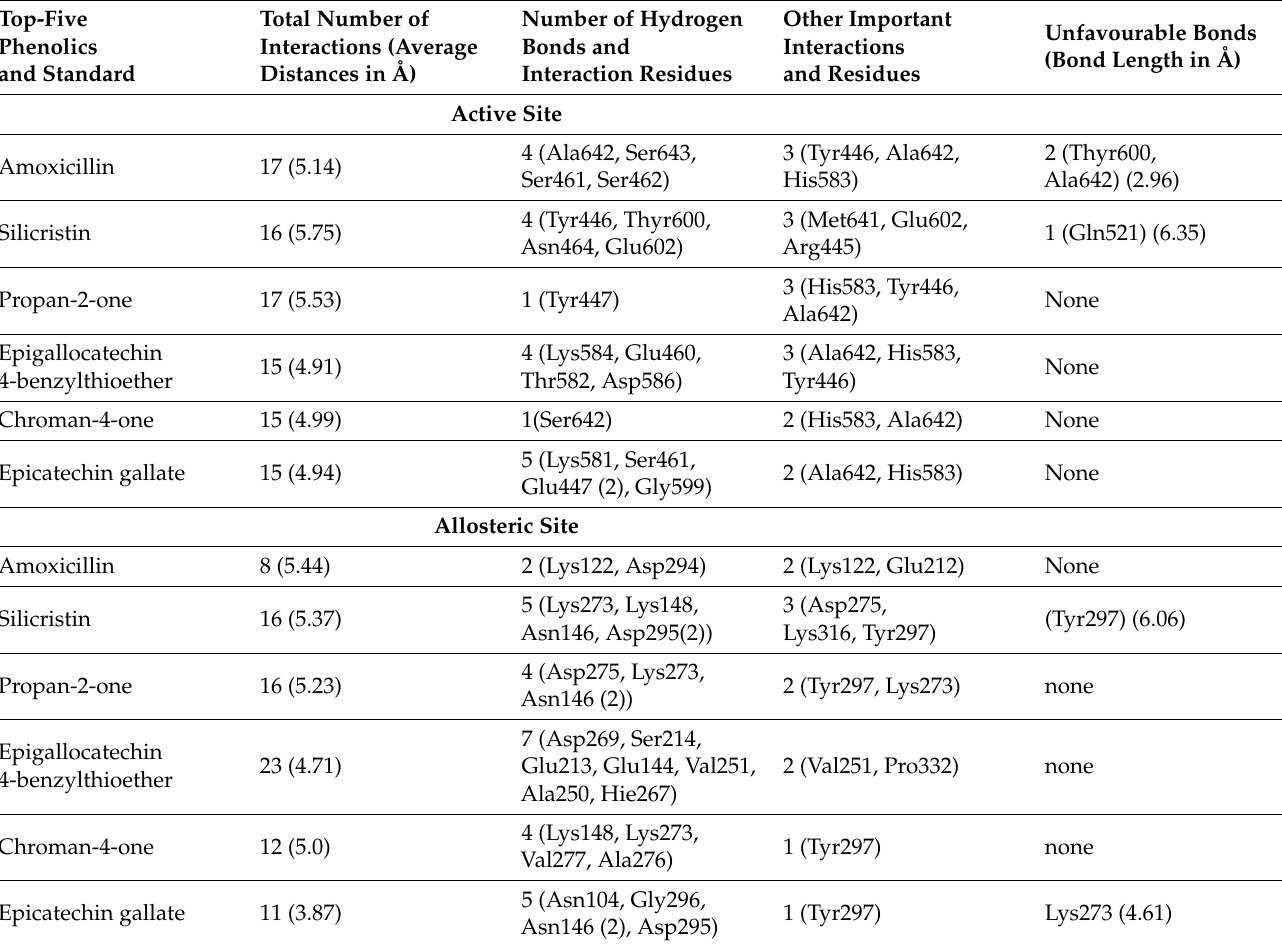
Table 7. Bond interactions against the active and allosteric site of PBP2a of S. aureus by the top- five